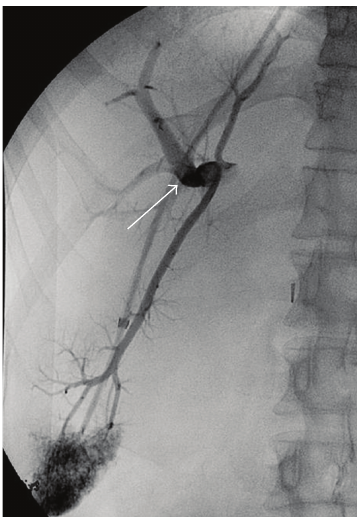
Figure 1: Wedged hepatic venography allowing intrahepatic portal vein localisation (arrow).